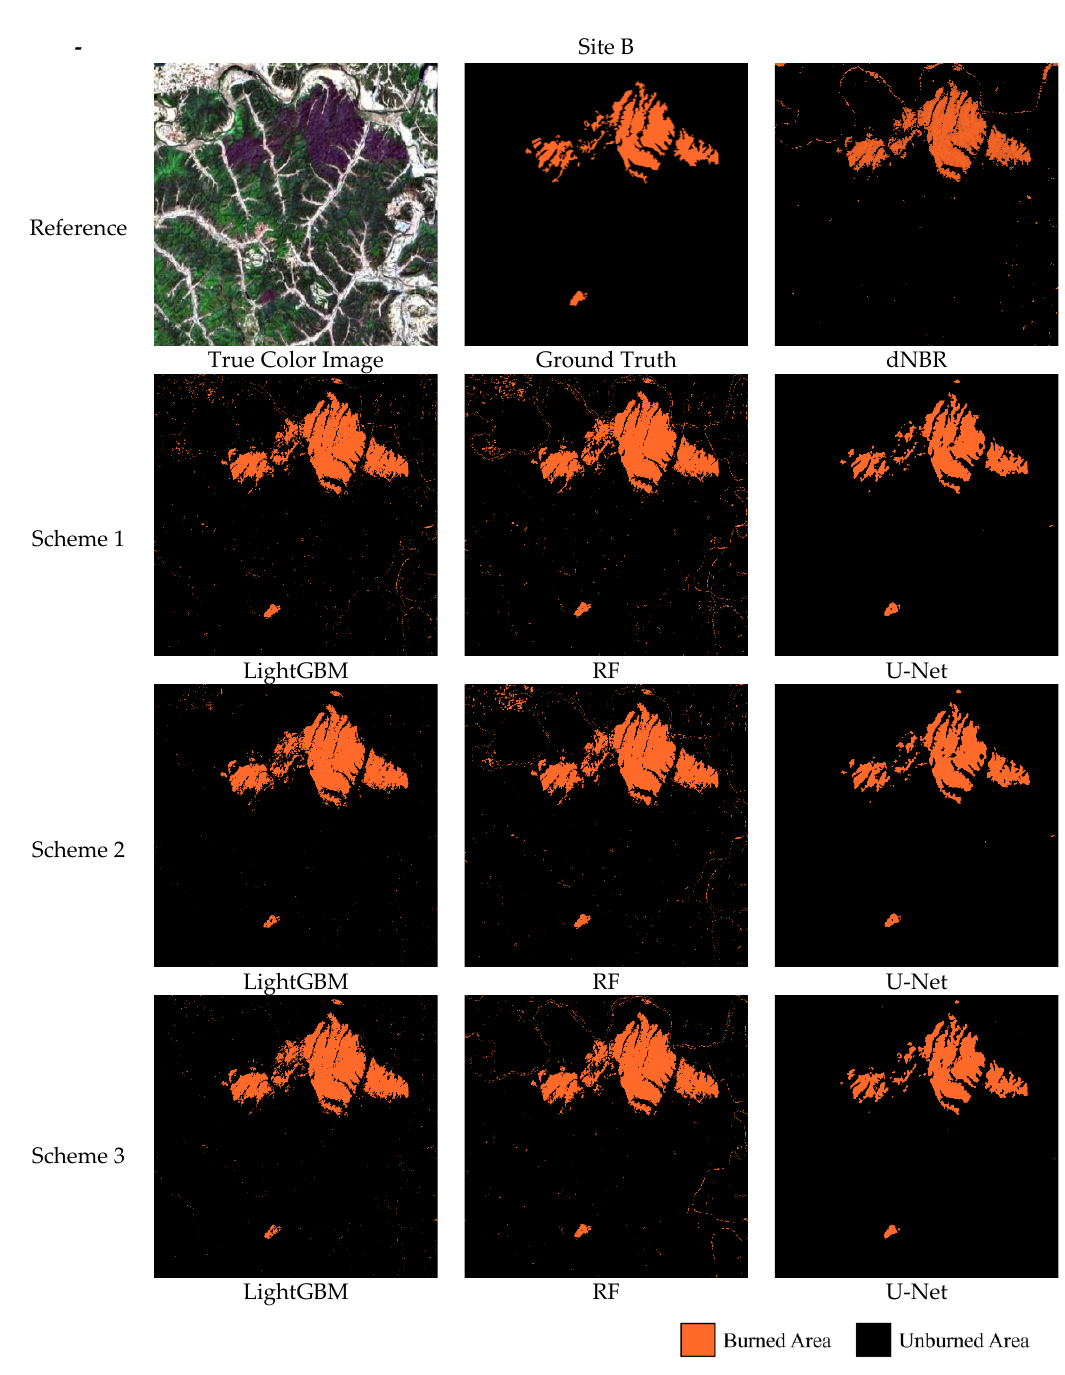
Figure 6. Spatial distribution of burned area detection results in Site B.